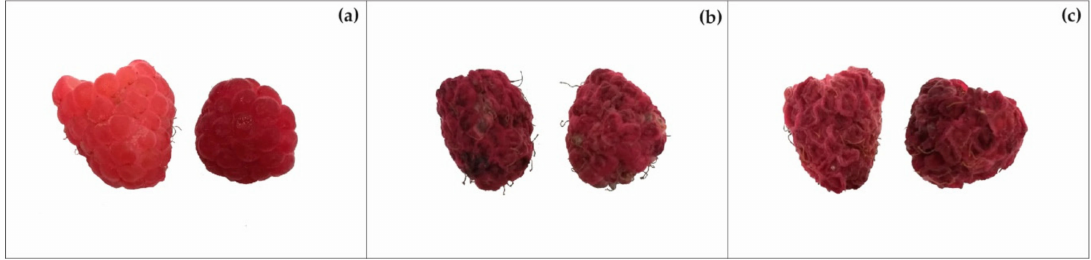
Figure 2. Fresh raspberries ( a ), ~80% moisture. Conventional hot air-dried raspberries ( b ), ~4% moisture. Heat pump-dried raspberries ( c ), ~14%